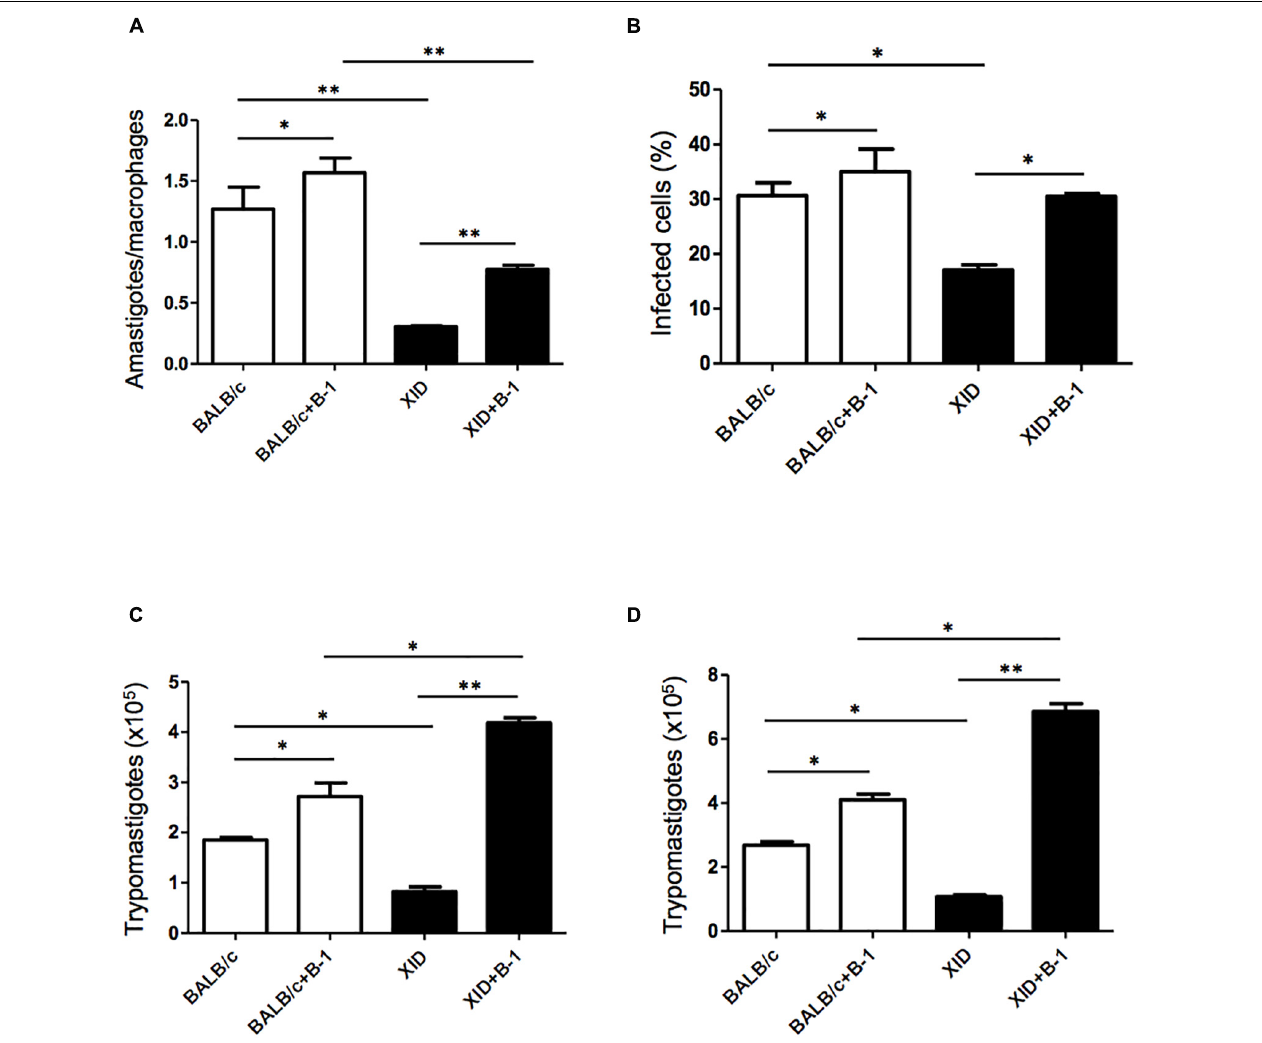
FIGURE 1 | Effect of B-1 cells in co-culture with macrophages infected by Trypanosoma cruzi . Peritoneal macrophages from BALB/c (white bars) or from XID mice (black bars) were plated (2 × 10 5 /mL) and infected with trypomastigotes forms of T. cruzi Dm28c clone at a 5:1 parasite-to-cell ratios in 1 mL of DMEM 10% FCS and incubated at 37 ◦ C in 5% CO 2 . After overnight incubation, the cell culture was washed and some cultures were co-cultivated with B-1 cells at a 10:1 B-1-to-macrophages ratios. After 3 days, cells were stained and amastigotes inside the macrophages were counted under light microscope (A) and set the percentage of infected cells (B) . To quantify trypomastigotes forms in the supernatants, the cells were infected with trypomastigotes forms of T. cruzi Dm28c clone. After overnight incubation, the cell culture was washed and some cultures were co-cultivated with B-1 cells at a 10:1 B-1-to-macrophages ratios for 7 (C) and 9 (D) days. All cultures were performed in triplicate and bars show the mean + SD. Statistical analysis was performed by t -test from representative results of three similar experiment ( ∗ p < 0.05 and ∗∗ p <